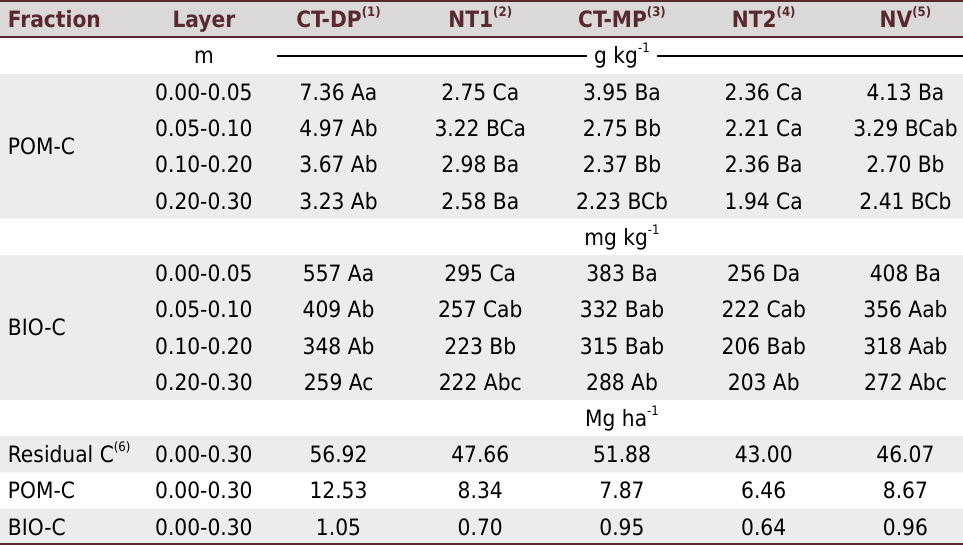
Table 4. Carbon compartments (particulate organic matter – POM-C, soil microbial biomass – BIO-C, and residual C) in a clayey Latossolo Vermelho Distrófico (Typic Haplustox) under different management systems in the